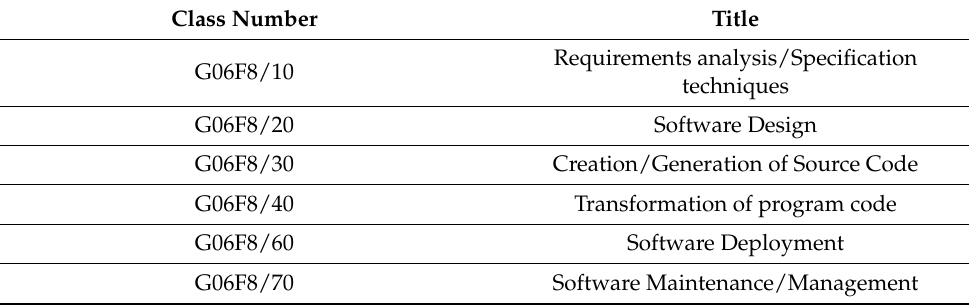
Table 1. Subclasses of G06F8 (arrangements for software engineering).